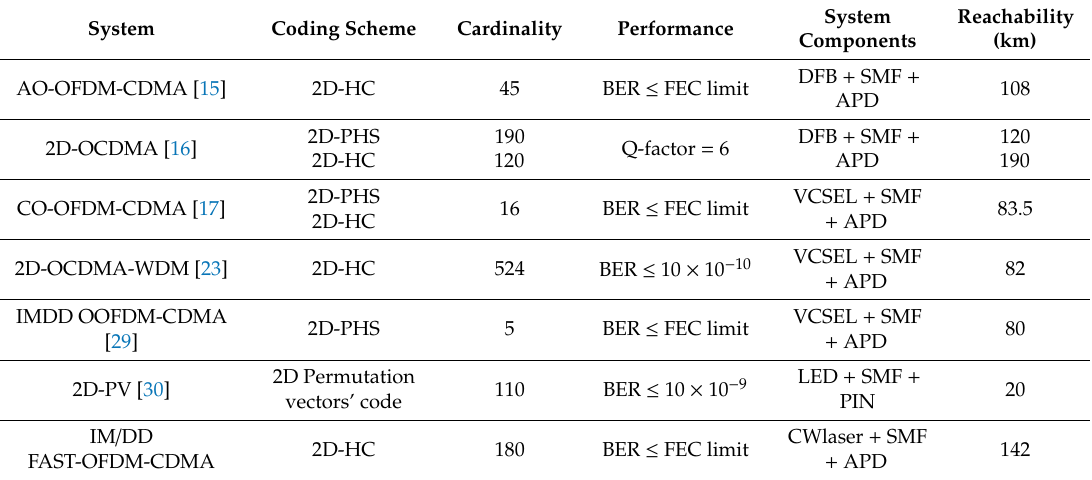
Table 5. Relevant 2D-OCDMA systems in PON